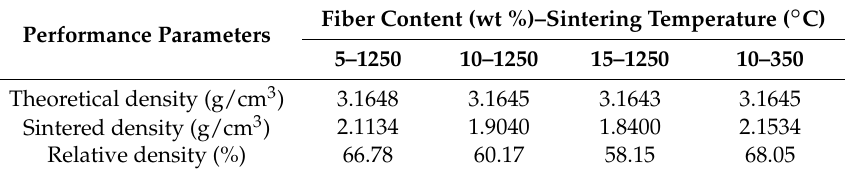
Table 1. Relative density of MF/HA